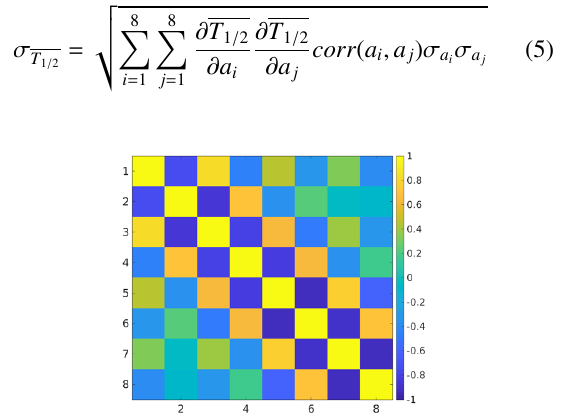
Figure 7: Correlation matrix associated with Foligno’s abundances